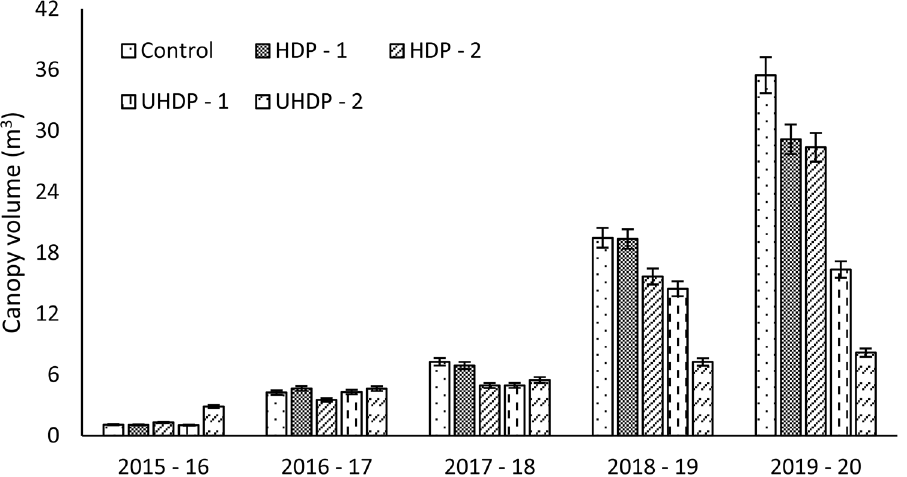
Figure 2. Effect of planting density on canopy volume of the plants. Control: Planting at 6 m (row to row) × 6 m (plant to plant) spacing (tree density—277 plants ha −1 ), HDP-1: Planting at 6 m (row to row) × 3 m (plant to plant) spacing (tree density—555 plants ha −1 ), HDP-2: Planting at 4 m (row to row) × 4 m (plant to plant) spacing (tree density—625 plants ha −1 ), UHDP-1: Planting at 4 m (row to row) × 2 m (plant to plant) spacing (tree density—1250 plants ha −1 ), UHDP-2: Planting at 2 m (row to row) × 2 m (plant to plant) spacing (tree density—2500 plants ha −1